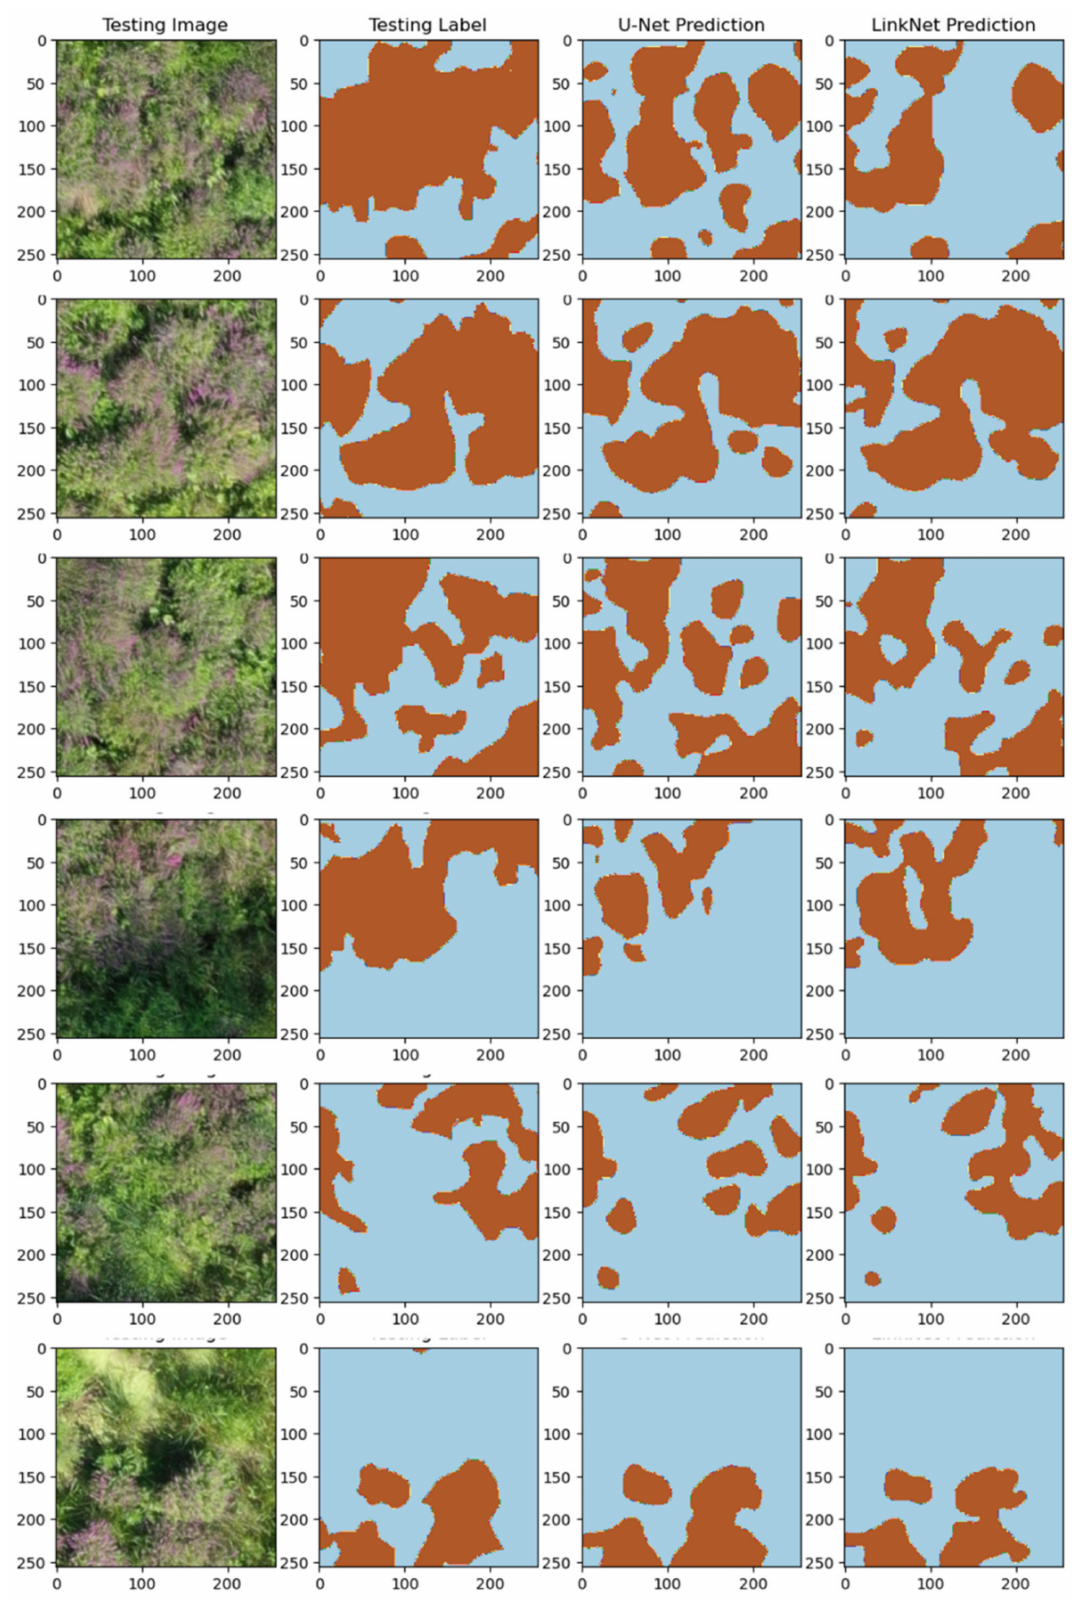
Figure 8. Predicted images of Brice Prairie (BP1) generated by the U-Net and LinkNet models of Lake Neshonoc (40